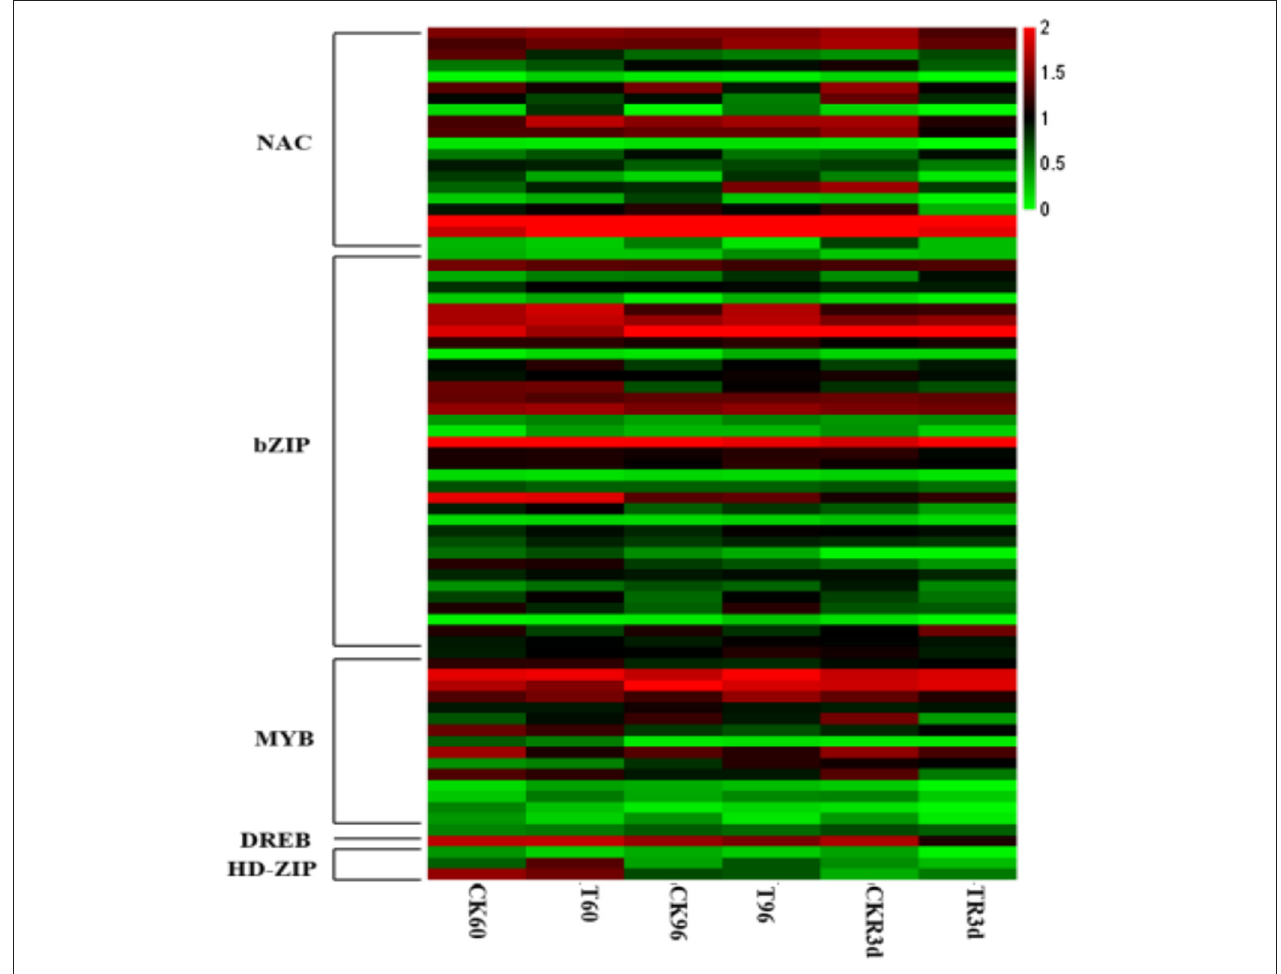
FIGURE 1 | The differential expression transcription factors in maize transcriptome sequencing under drought stress and